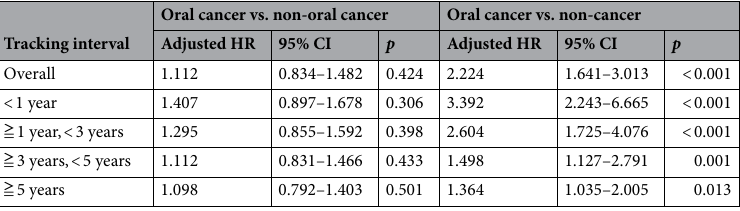
Table 4. Sensitivity analysis for factors of depression by using Cox regression. HR hazard ratio, CI confidence interval, Adjusted HR adjusted variables listed in Table